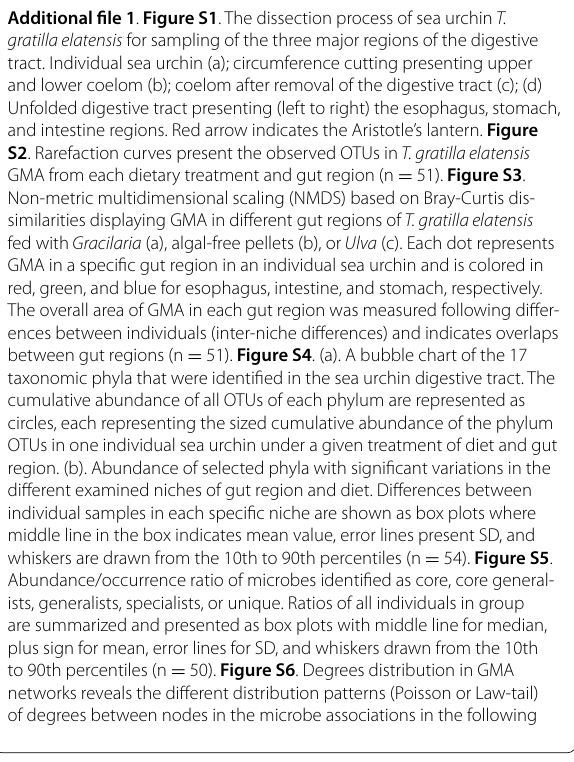
Table S1 . Ingredients in the formulated algal‑free, plant‑based pellets for T. gratilla elatensis used in current study. Table S2 . Physical characteristics of wet weight and diameter (mean SE) of sea urchin individuals after ± culture under the different diet‑ types of Ulva , or Gracilaria , or pellets. Values are mean SE (n 3). n.d. not determined. Table S3 . OTU count ± = = and number of reads for each of the examined samples from a particular